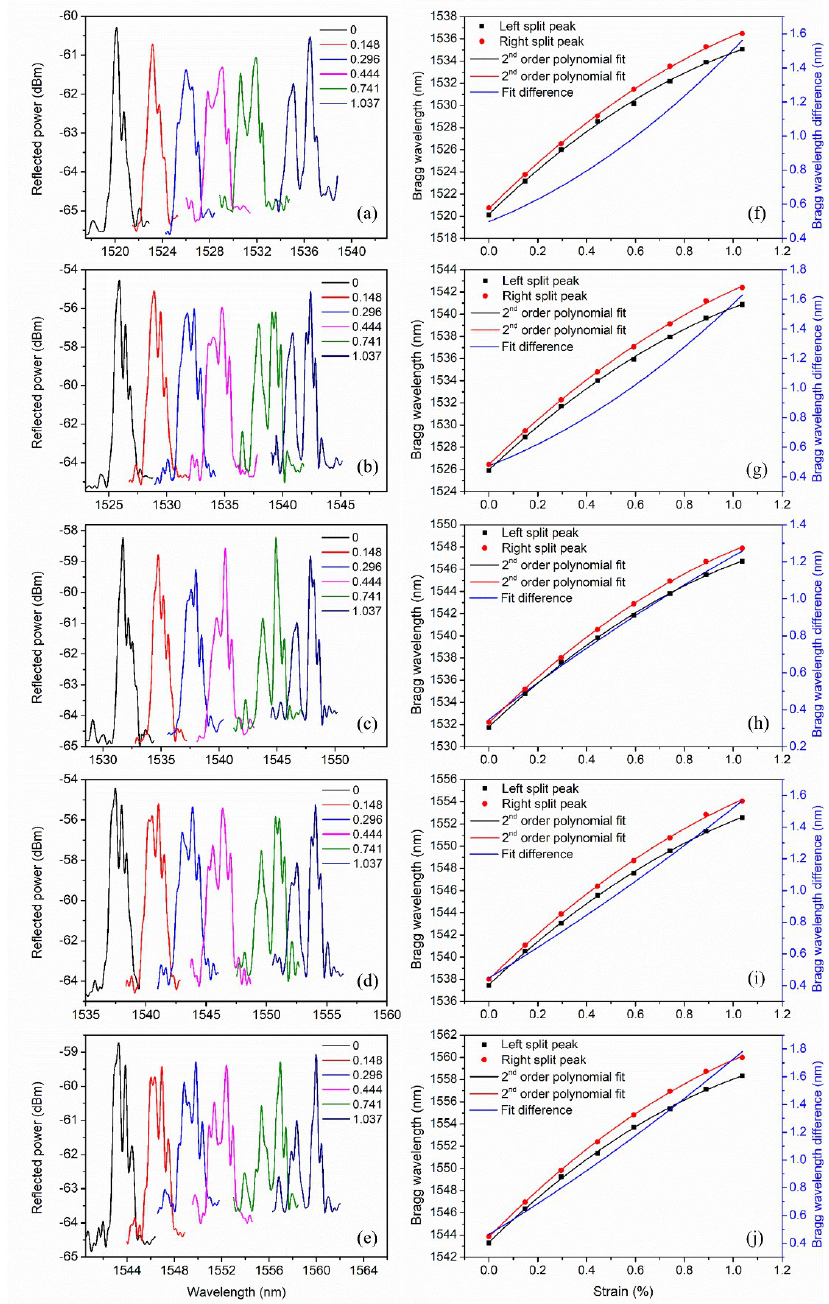
Figure 8. The spectra of peaks 1 – 5 ( a – e ) and the Bragg wavelength shift of the split peaks for peaks 1 – 5 ( f – j ) in terms of the strain from 0% to 1.037% for FBG 3 in the second regime.